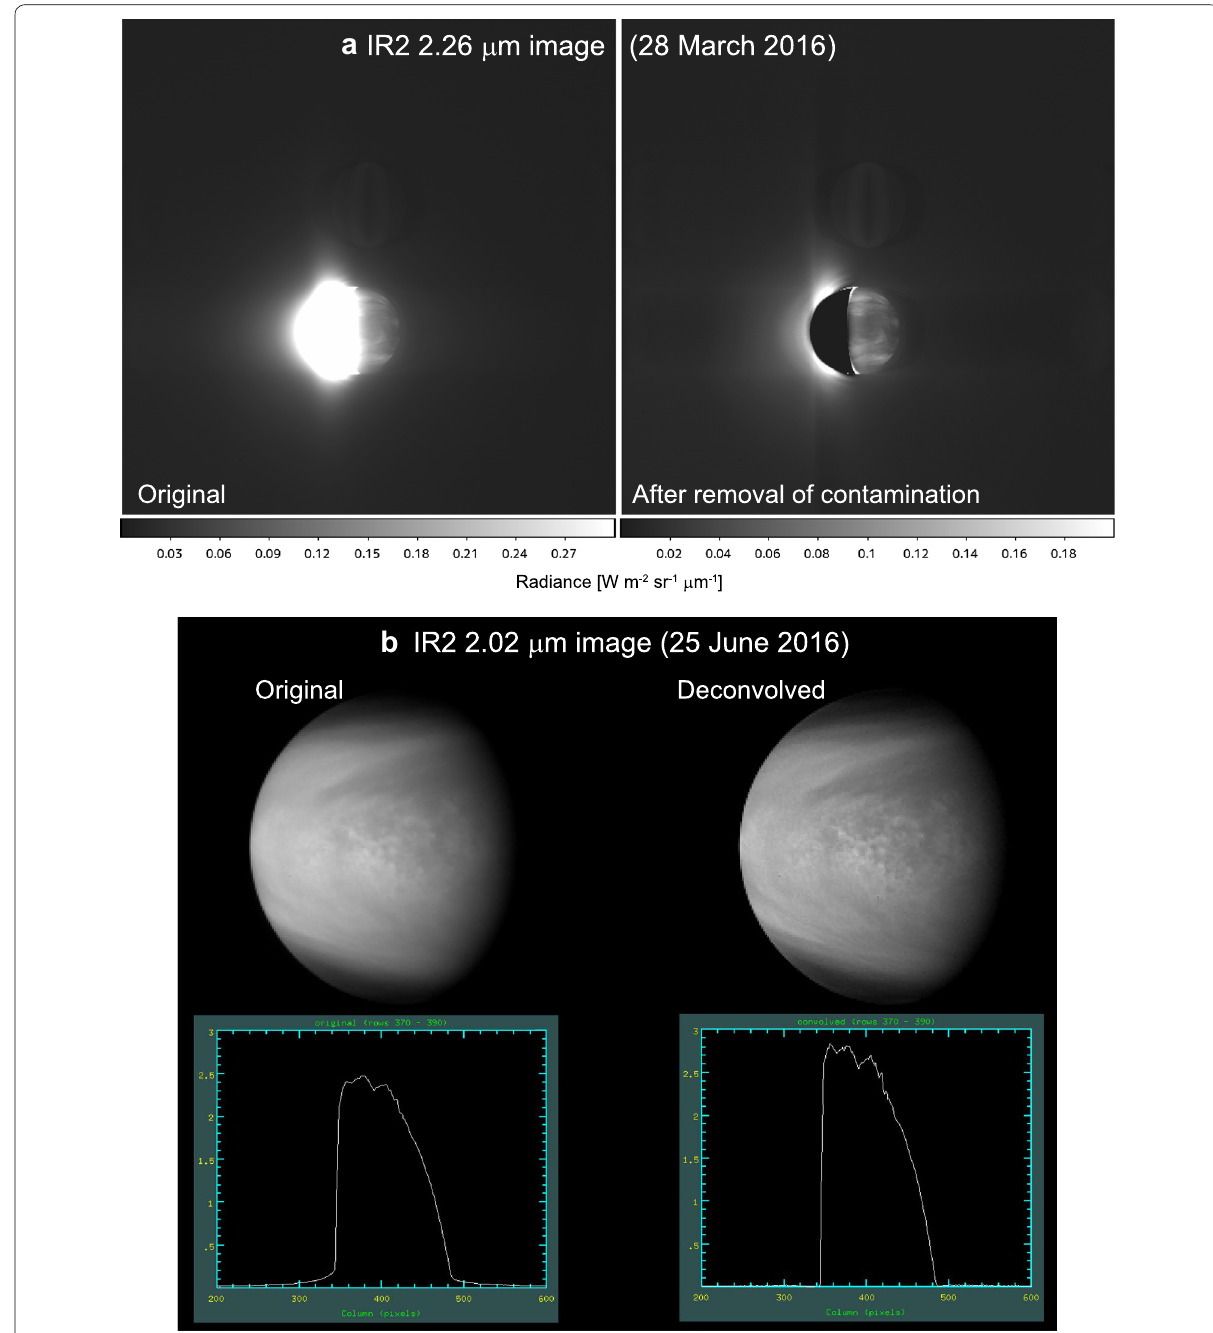
Fig. 8 Application of IR2 PSF to Venus images. a Demonstration of removal of contamination of the night‑side disk by the intense dayside disk (2.26 μm, acquired on March 28, 2016). The procedure is described in the text. After removal of the contamination, the electrical artifacts of the IR2 image become more noticeable. b Demonstration of deconvolution (Lucy–Richardson algorithm) performed on a 2.02‑μm dayside disk (June 25, 2016). The PSF in Fig. 7b is used for this restoration, and no significant artifact is